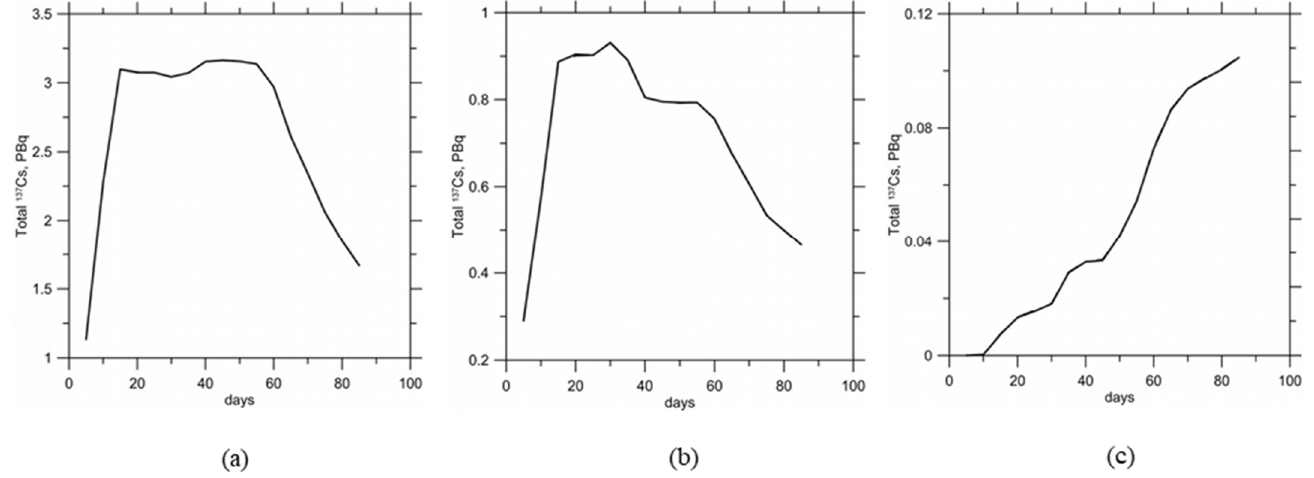
Figure 18. ( a ) Total amount of dissolved 137 Cs after release from the Kuosheng NPP; ( b ) total amount of 137 Cs adsorbed on suspended sediments after release from the Kuosheng NPP; ( c ) total amount of bottom contamination of 137 Cs after release from the Kuosheng NPP.